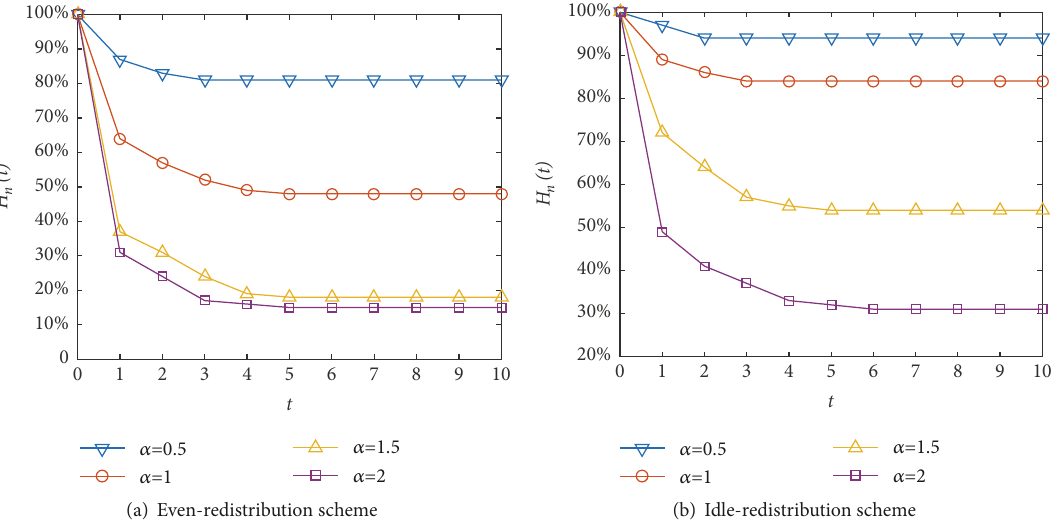
Figure 7: Survival ratio with varying 𝛼 ( 𝛽 = 1 , Δ𝑡 = ∞ ).